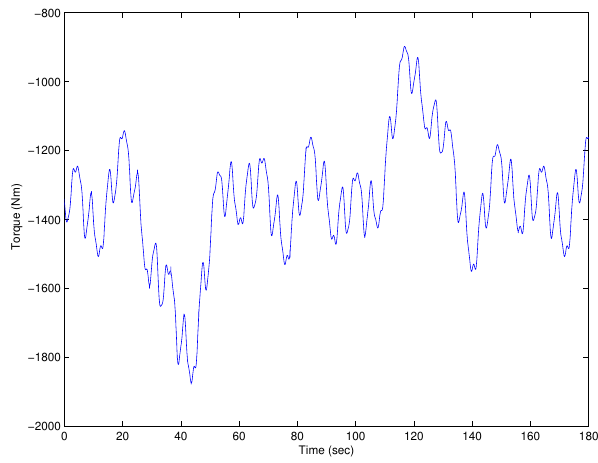
Figure 11. The electromagnetic torque T em versus time.